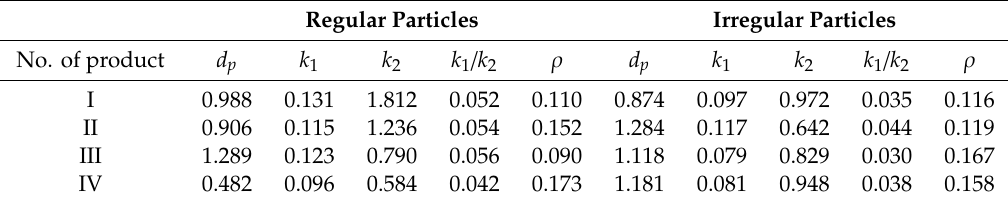
Table 1. Comparison of the standard deviation from the mean values for all the calculated